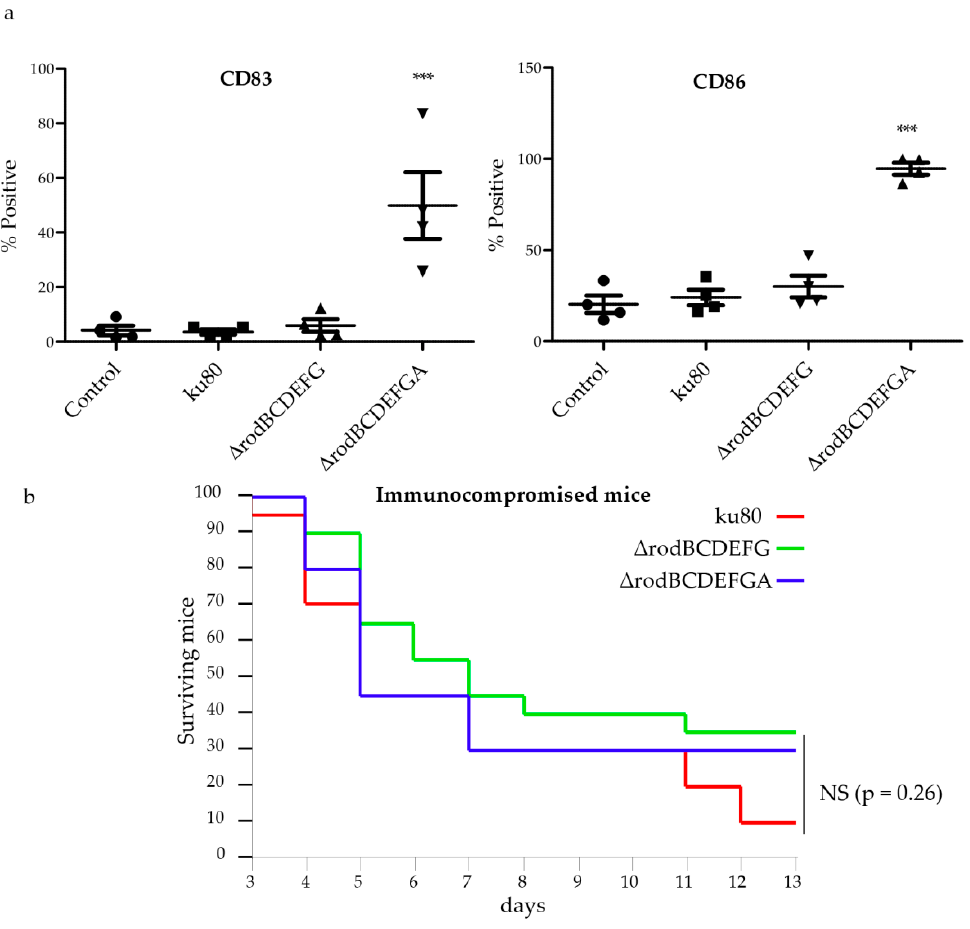
Figure 7. Virulence of hydrophobin mutant conidia. Effect on the maturation of human DCs ( a ); control represents non-stimulated DCs; infection of immunocompromised mice ( b ). *** p < 0.001; NS: non-significant.